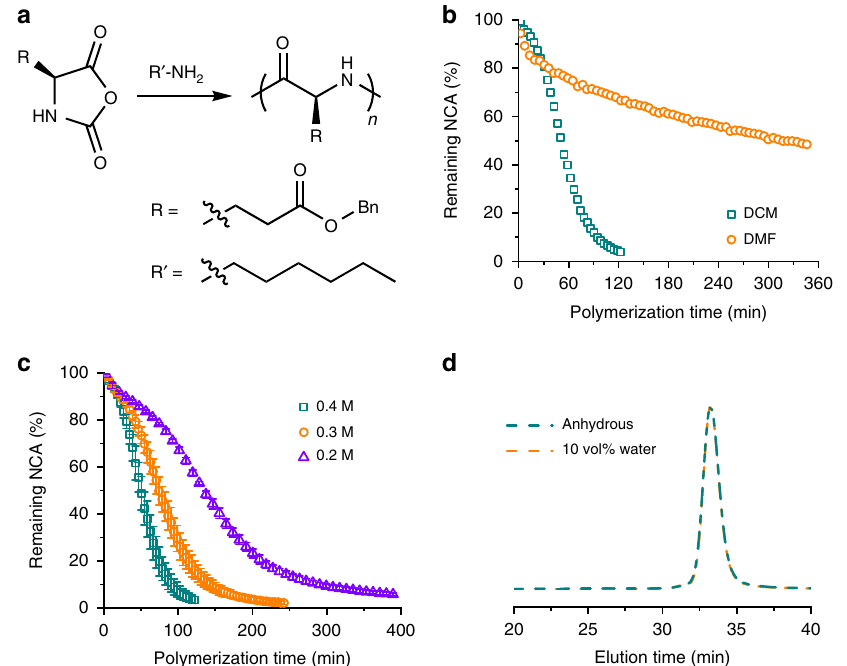
Fig. 2 Polymerization kinetics of BLG-NCA. a Scheme showing the polymerization of BLG-NCA initiated by n -hexylamine. b Conversion of BLG-NCA in anhydrous DCM and DMF. [M] 0 = 0.4 M, [M] 0 /[I] 0 = 100. c Conversion of BLG-NCA in DCM at various [M] 0 . [M] 0 /[I] 0 = 100. Error bars represent standard deviations from three independent measurements. d Normalized GPC-LS trace of obtained PBLG from polymerization of BLG-NCA in DCM under anhydrous conditions or in the presence of 10 vol% water. [M] 0 = 0.4 M, [M] 0 /[I] 0 = 100.